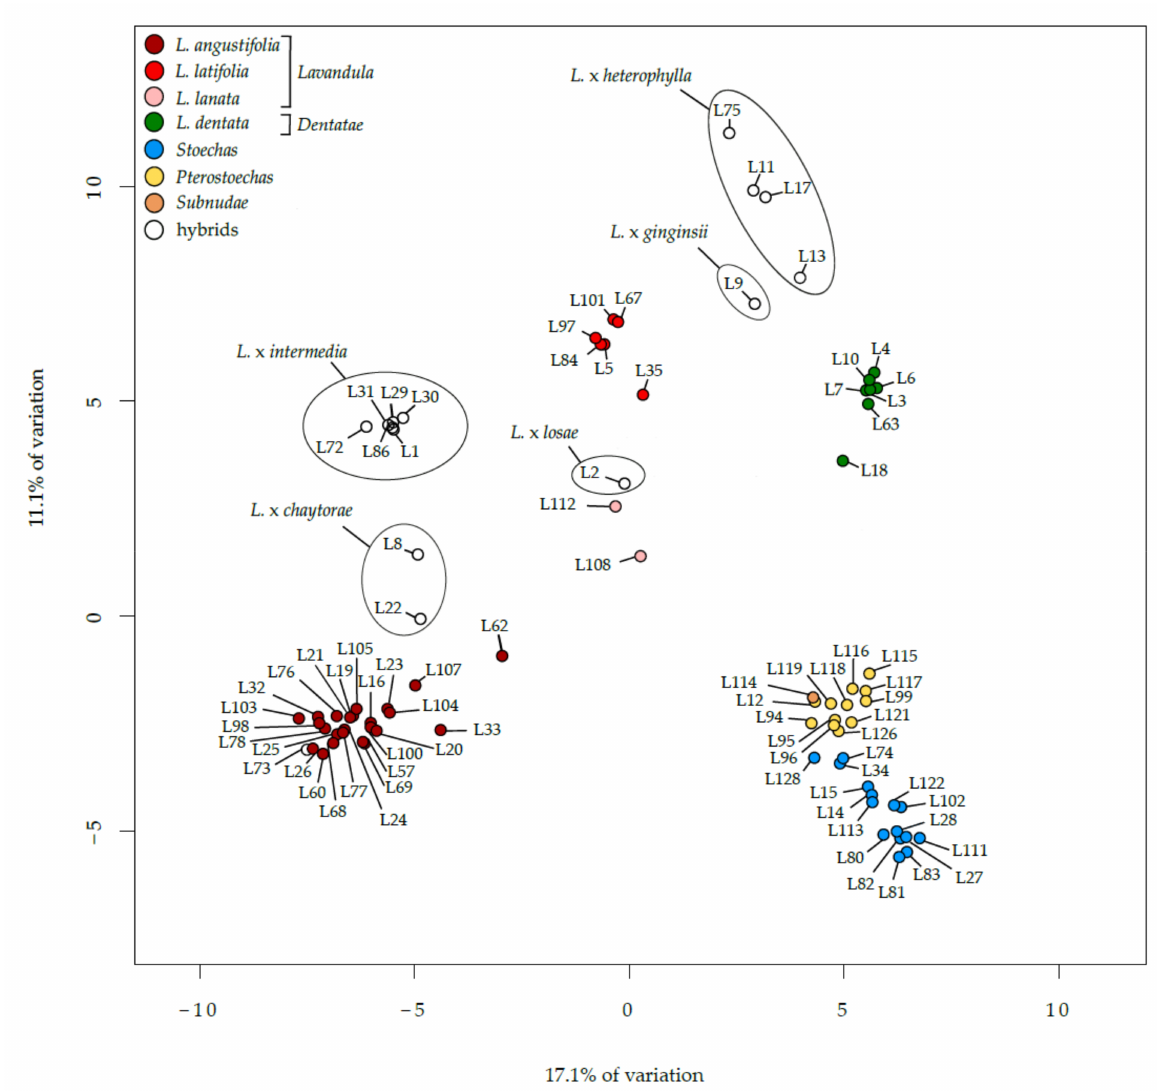
Figure 4. Principal Coordinate Analysis (PCoA) plot based on AFLP data of 82 genotypes of Lavandula . Different sections or species of the genus are indicated with different colors. The X- and Y-axis comprise 17.1% and 11.1% of the variation, respectively. Hybrid groups are